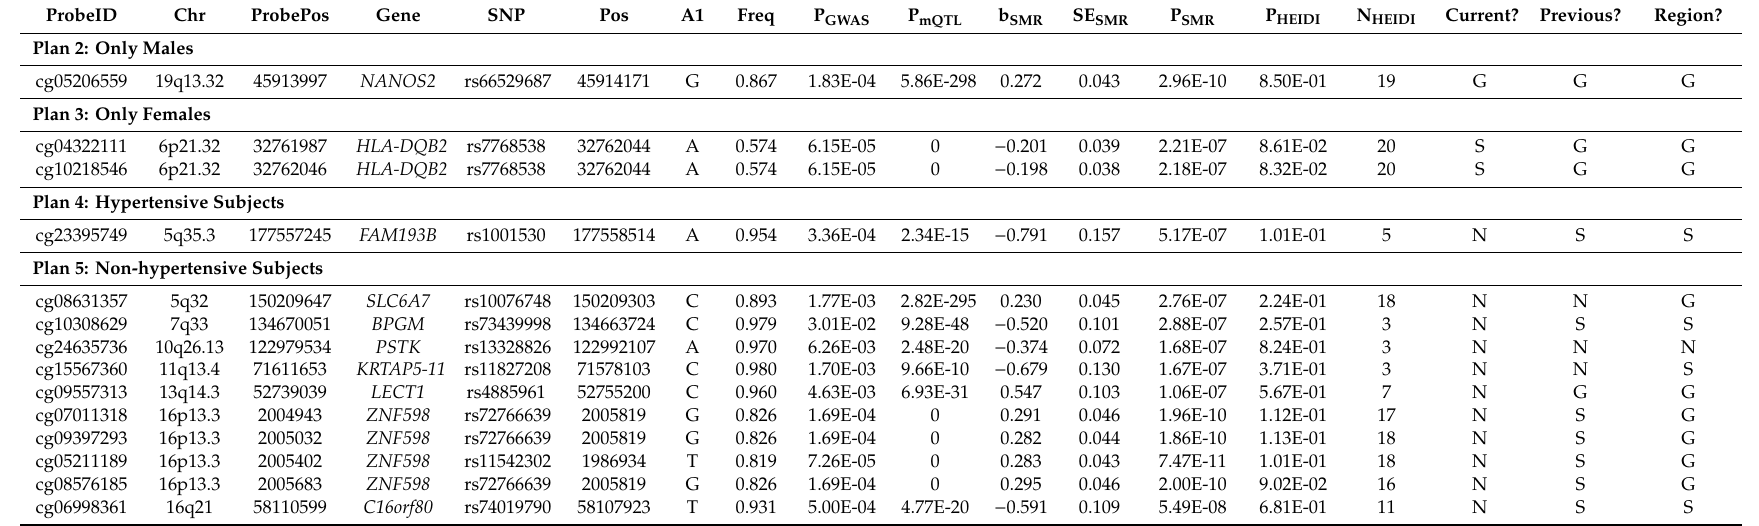
Table 2. Brain-specific methylome-wide association results for genes that had significant probes in both brain-specific and blood-based analyses.